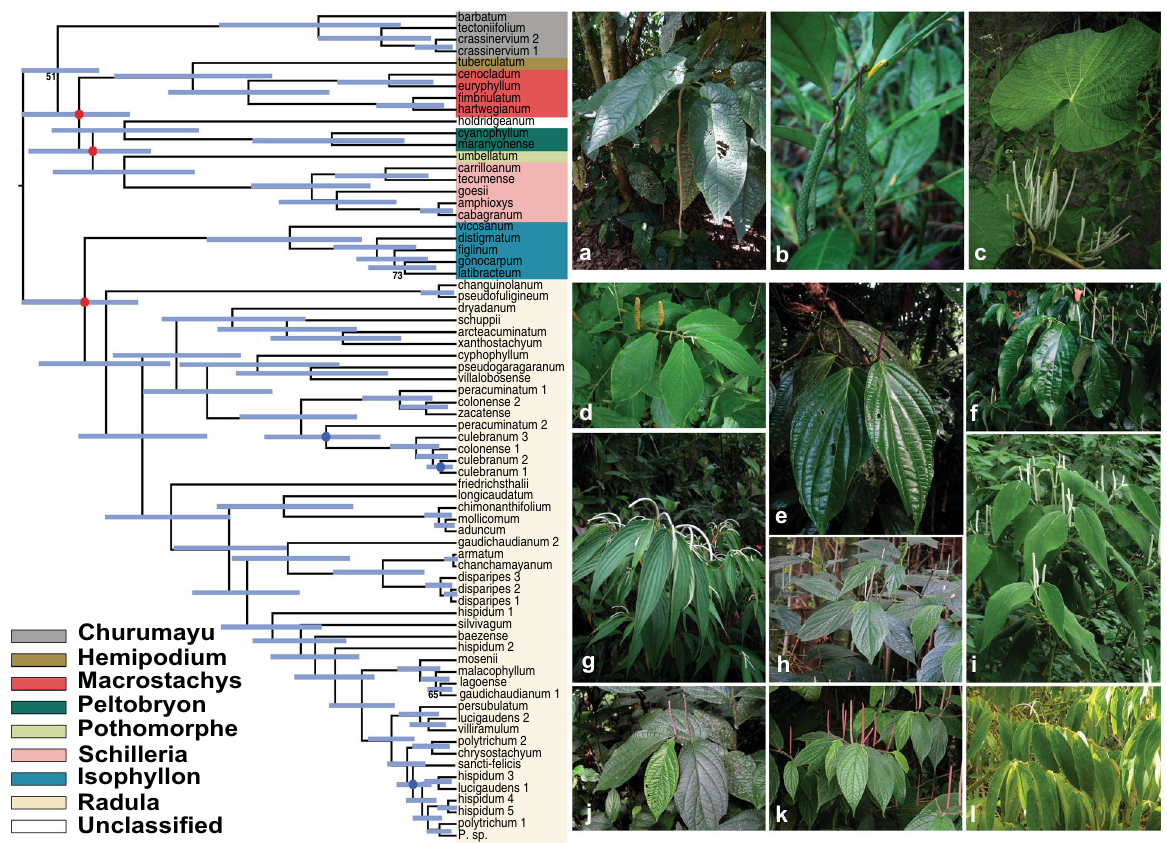
Figure 1. Maximum clade credibility tree of 48 samples from the Radula clade of Piper and 23 outgroup species inferred with a Bayesian analysis of 641 concatenated ddRADseq loci (55,298 base pairs) comprising 9113 genetic variants (of which 4674 are parsimony informative). The outgroup taxa were sampled across multiple Piper clades: Churumayu, Isophyllon, Hemipodium, Macrostachys, Peltobryon, Pothomorphe, and Schilleria. All nodes are supported by at least 95% posterior support except where noted with circles or labels. Blue circles indicate support values between 85 and 95%. Red circles indicate support values between 75 and 85%. Three nodes with less than 75% posterior support were given numerical support values. Blue bars at each node denote the 95% highest posterior density interval on relative node ages. The photos to the right of the tree showcase a sample of Piper diversity, including a few of the species which were included in this study: ( a ) Piper hillianum (Macrostachys), ( b ) P. acutifolium (Peltobryon), ( c ) P. umbellatum (Pothomorphe), ( d ) P. pseudofuligineum (Radula), ( e ) P. concepcionis (Radula), ( f ) P. disparipes (Radula), ( g ) P. friedrichsthalii (Radula), ( h ) P. dilatatum (Radula), ( i ) P. bredemeyeri (Radula), ( j ) P. immutatum (Radula), ( k ) P. erubescentispicum (Radula), and ( l ) the widespread and often weedy P. aduncum (Radula). (Photo credits: E. J.